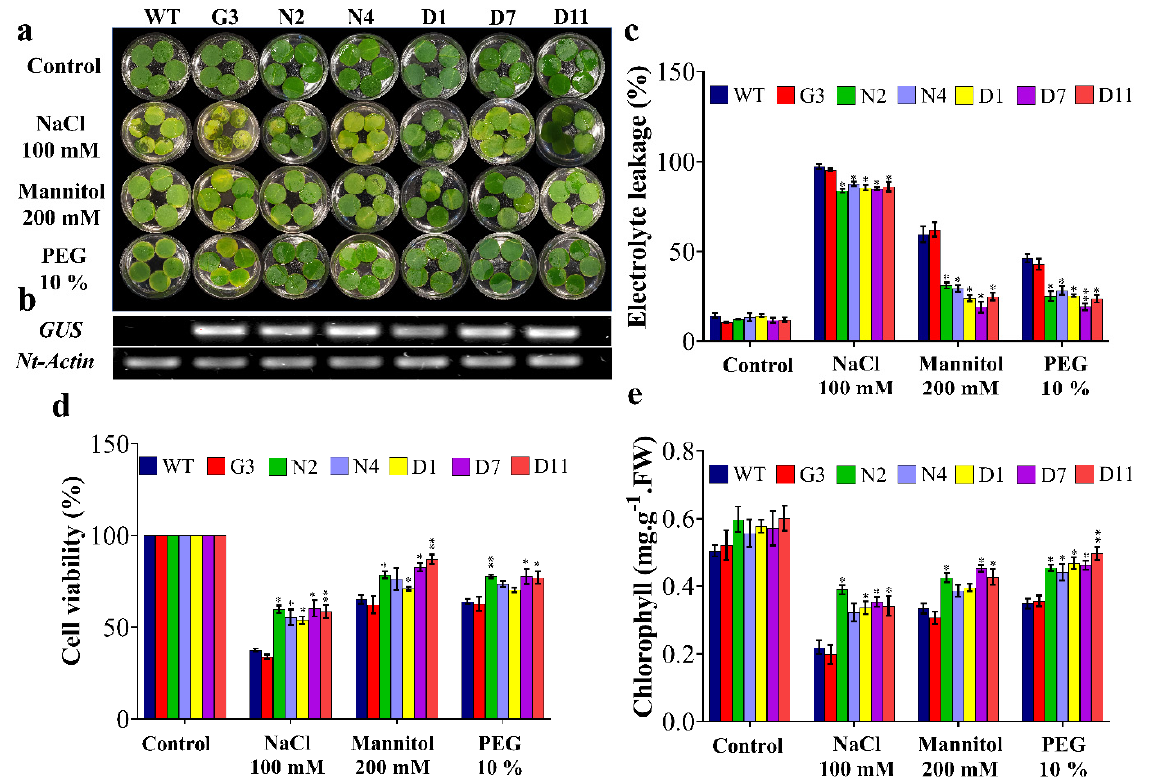
Figure 5. Leaf disc senescence assay and physiological analyses of transgenic lines under stress conditions. ( a ) The leaf discs of F 1 transgenic lines and WT plants were incubated under NaCl (100 mM), mannitol (200 mM) and PEG (10%) stresses. Control refers to leaf discs at 0 days; stress treatments show leaf discs after nine days of incubation. ( b ) Overexpression of GUS in transgenic lines compared to wild-type control plants. ( c ) Estimation of the electrolyte leakage percentage, ( d ) cell viability, ( e ) total chlorophyll. The bars represent mean values ± SEM of three biological replicates (four plants each). Asterisk(s) indicate(s) significant differences between the means of wild type (WT) and transgenic line of each treatment group at * p < 0.05, ** p < 0.01 according to Dunnett test.